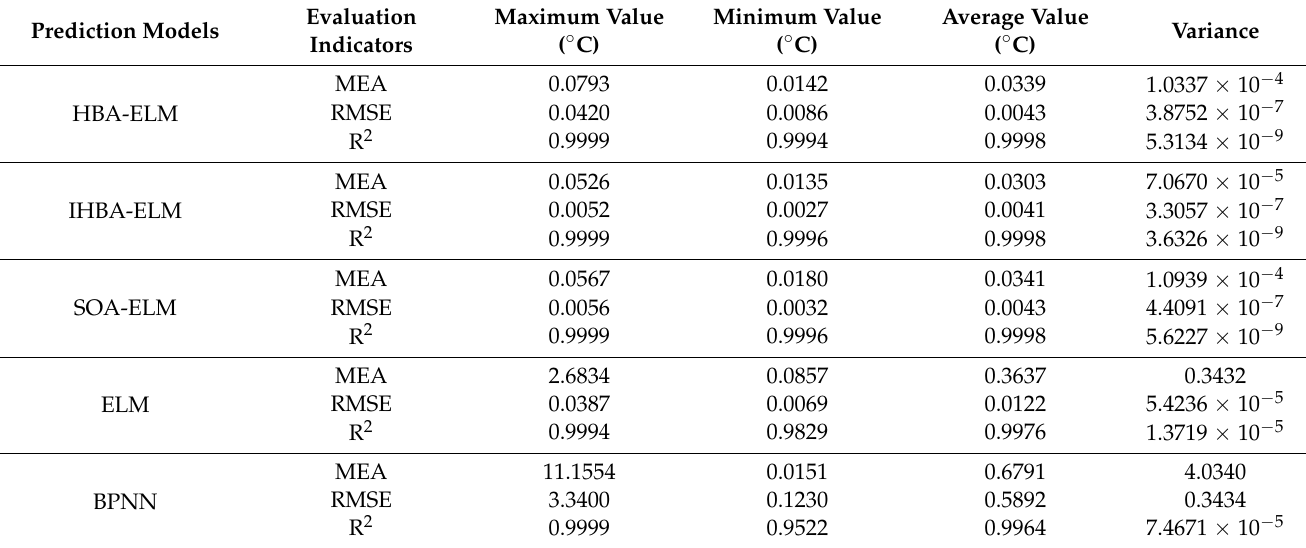
Table 3. Analysis of the results of junction temperature